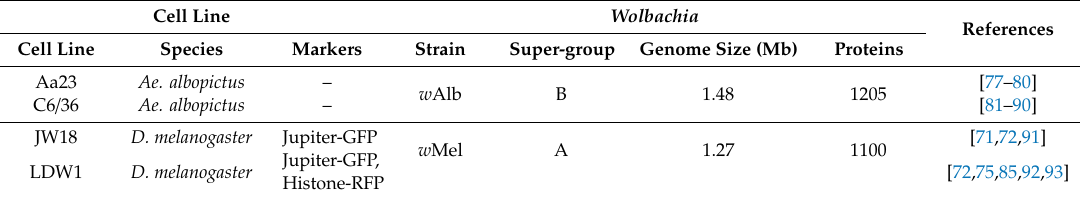
Table 5. Insect cells used for antiwolbachial high-throughput screening and features of Wolbachia strains